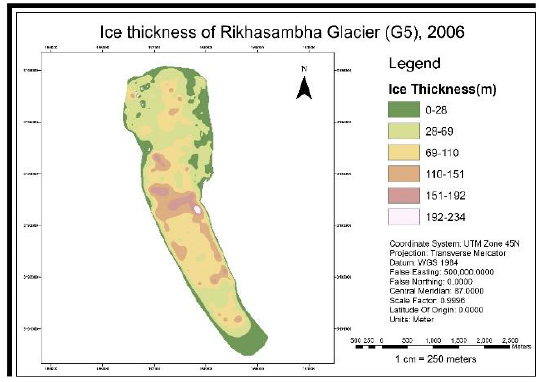
Figure 4. Thickness of Rikhasambha Glacier at 1996.